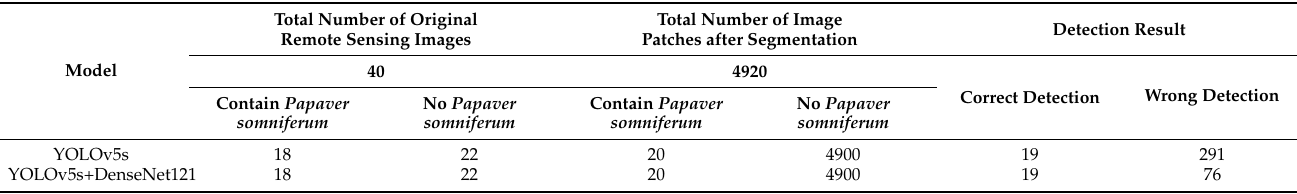
Table 10. Comparison of results between one-stage and two-stage